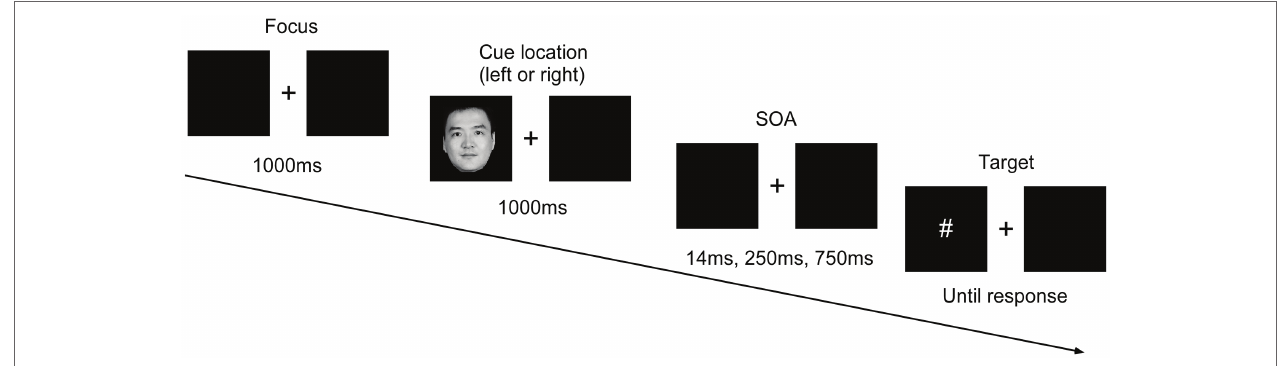
FIGURE 1 | Sequence of events in a single trial. SOA, stimuli onset asynchrony. Written informed consent was obtained from the depicted individual for the publication of his identifiable image.